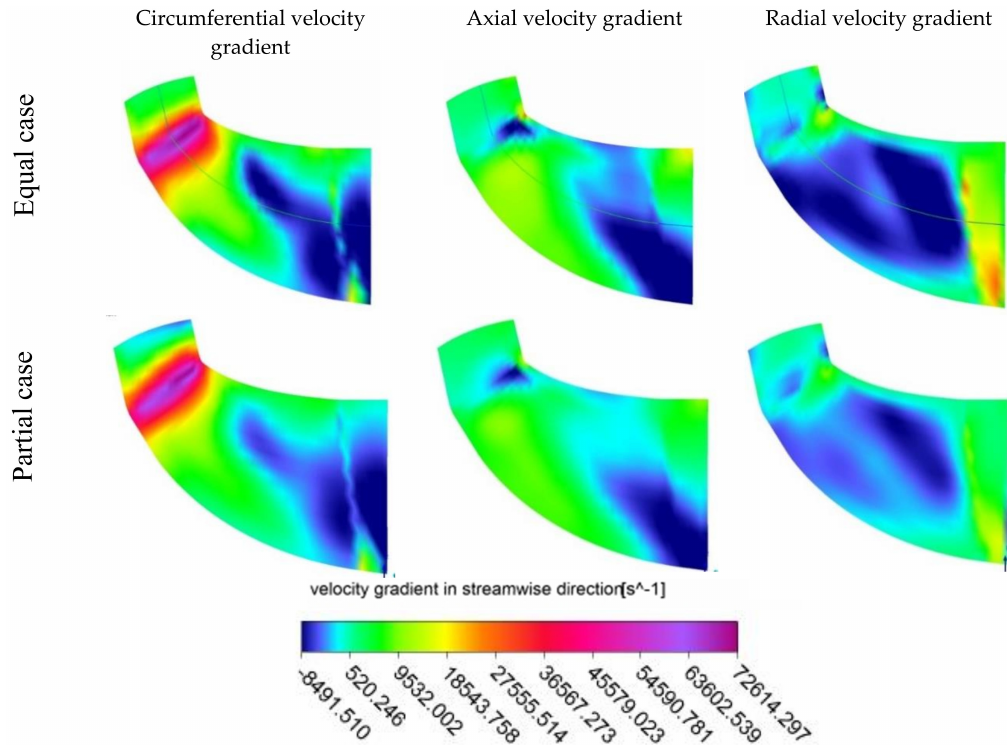
Figure 11. Meridional view of velocity component gradients in the streamwise direction in equal and partial